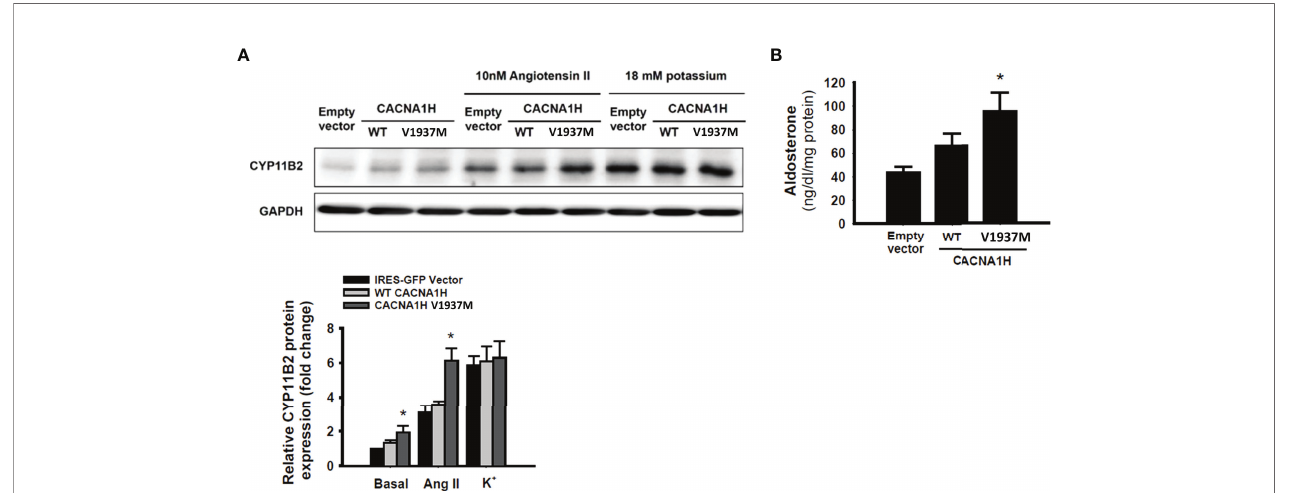
FIGURE 4 | CACNA1H p.V1937M mutation increased CYP11B2 expression and aldosterone production. The HAC15 cells were transiently transfected with wild- type or mutant CACNA1H p.V1937M. The samples and culture medium were analyzed at 72 h after transfection. (A) The CYP11B2 protein expression in wild-type CACNA1H or CACNA1H p.V1937M transfected cells was determined in basal condition or stimulation with angiotensin II (10nM) or potassium (18mM). (B) The aldosterone production was higher in cells harboring CACNA1H p.V1937M mutant than either control or wild-type CACNA1H transfected cells under angiotensin II- stimulated condition. * indicated P < 0.05 vs wild-type KCNJ5